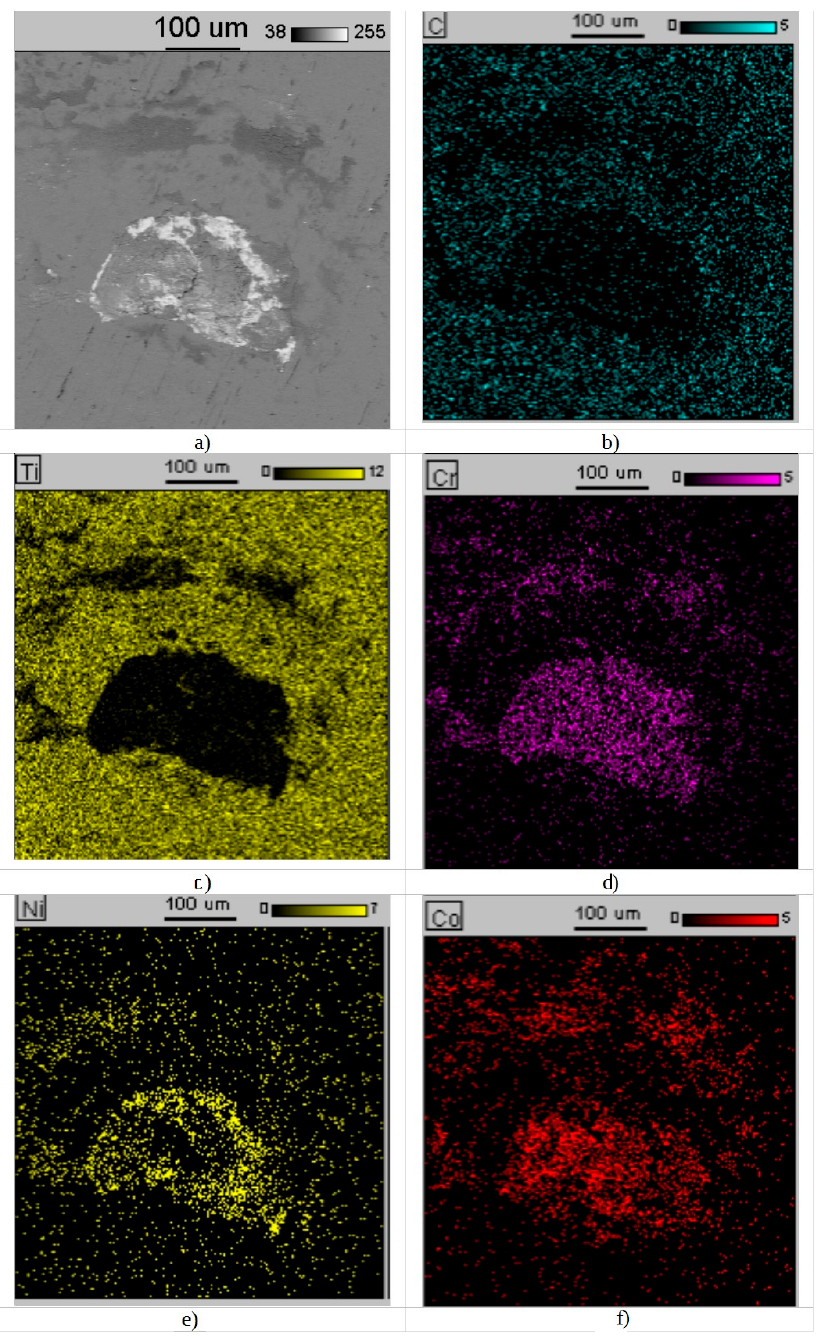
Figure 8. Microscopic image ( a ) and element distributions ( b – f ) in the friction area of sample S1. Parameters-load 15 N, time 120 min.